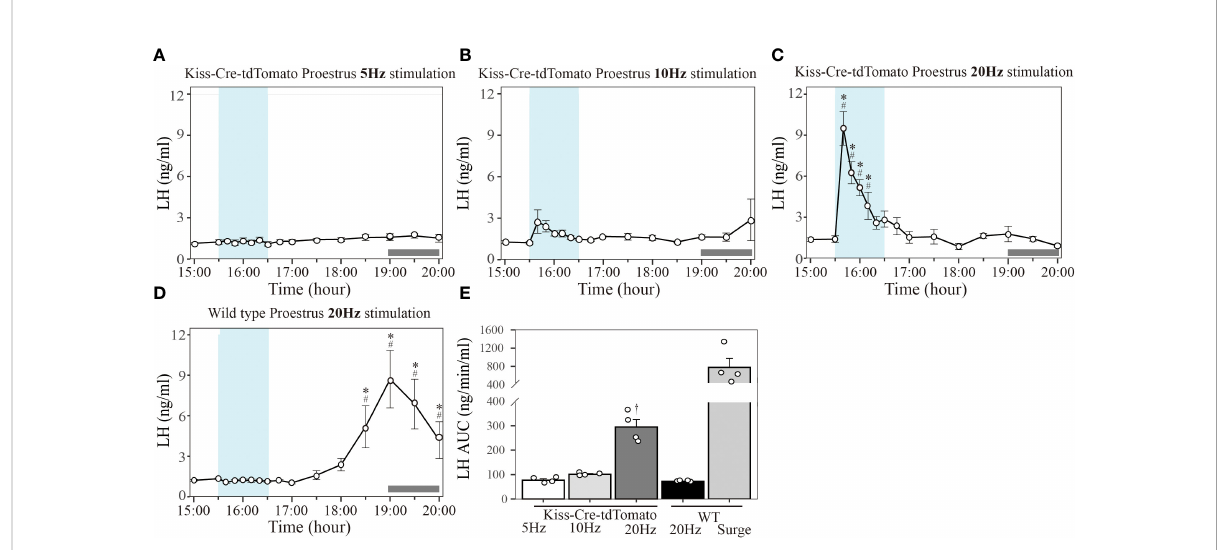
FIGURE 3 Effect of different frequency of optogenetic stimulation of Kiss1 ARC neuron terminals in the AVPV on LH secretion in proestrous mice. Circulating levels of LH (Mean ± SEM) in response to: (A) 5 Hz optical stimulation in proestrous Kiss-Cre-tdTomato mice (n = 4), (B) 10 Hz stimulation in proestrous Kiss-Cre-tdTomato mice (n = 4), (C) 20 Hz stimulation in proestrous Kiss-Cre-tdTomato mice (n = 4) and (D) 20 Hz stimulation in proestrous wild type (WT) mice (4/5 mice showed a spontaneous LH surge). (E) The AUC for LH secretion during a 1-h optic stimulation (15:30 – 16:30 h) at 5, 10 and 20 Hz in Kiss-cre mice, and 20 Hz stimulation in WT mice. Individual data points were shown as black circles. AUC for the spontaneous LH surge (17:30 – 20:00 h) in WT mice is also indicated in (E) . Grey bar on abscissa represents the light-off. *P < 0.05 represents signi fi cant difference relative to baseline LH levels at 15:00 h (-30 min). # P < 0.05 represents signi fi cant difference of 20 Hz stimulation group relative to 5 Hz and 10 Hz at the same time point. † P < 0.05 relative to other LH AUC treatment